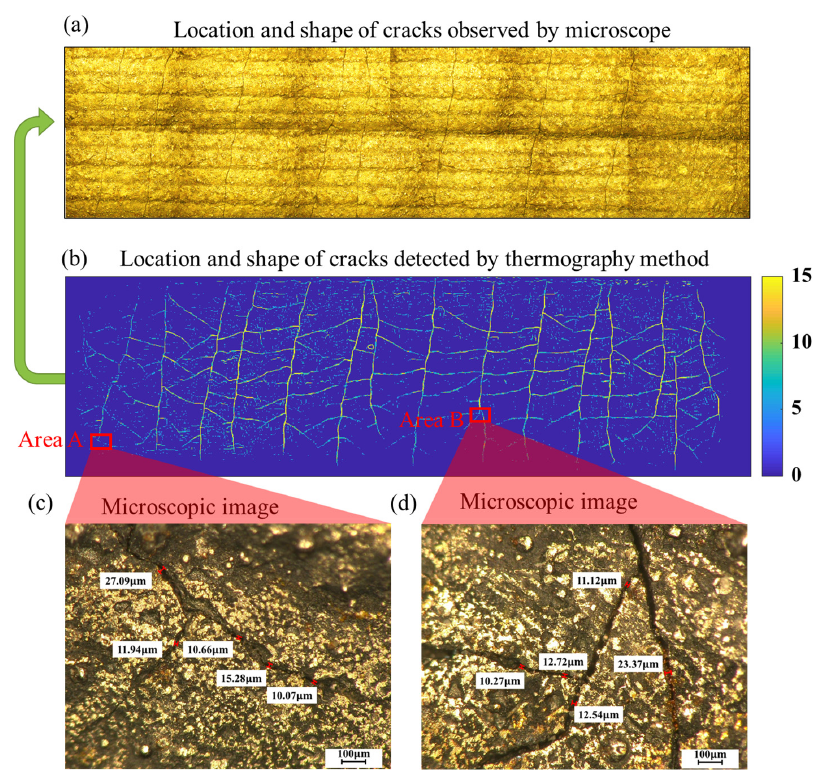
Figure 18. Comparison of laser scanning thermography detection result and microscope observations result of surface cracks in Area-1: ( a ) microscopic observation of surface cracks (50 × ); ( b ) surface crack detection result based on thermography; ( c ) cracks width measurement in area A under microscope; ( d ) cracks width measurement in area B under microscope.